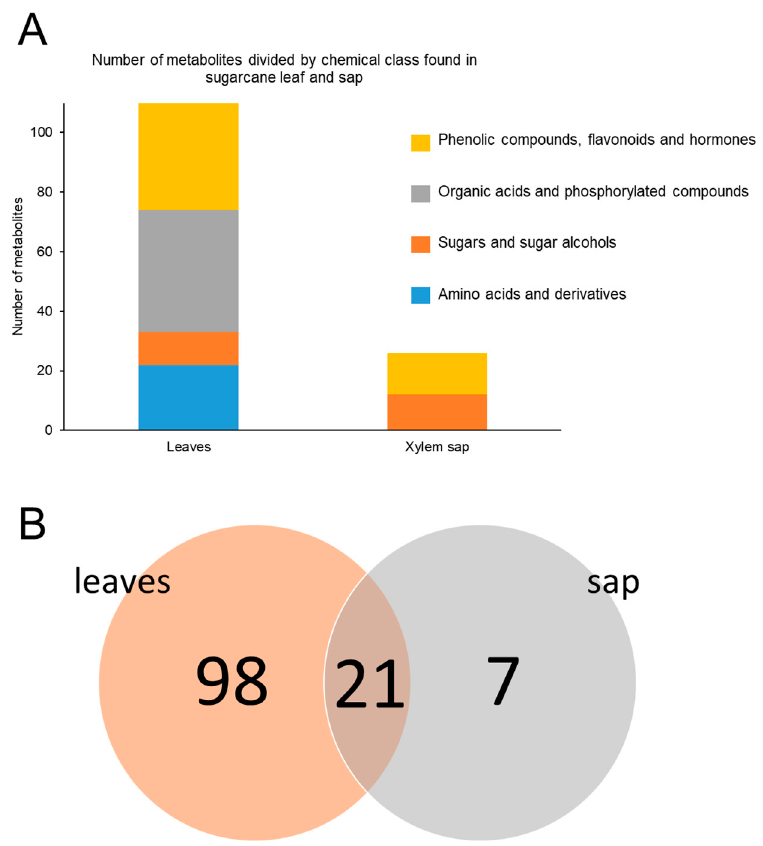
Figure 2. Number of compounds detected and quantified by targeted metabolomics grouped according to their chemical class ( A ) and numbers of unique or shared compounds in the leaves and xylem sap ( B ).